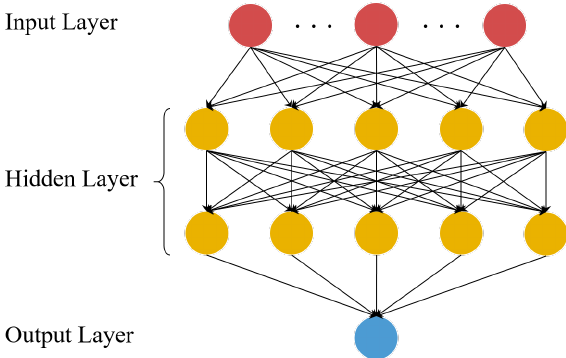
Figure 5. An example of fully-connected deep neural network (DNN)